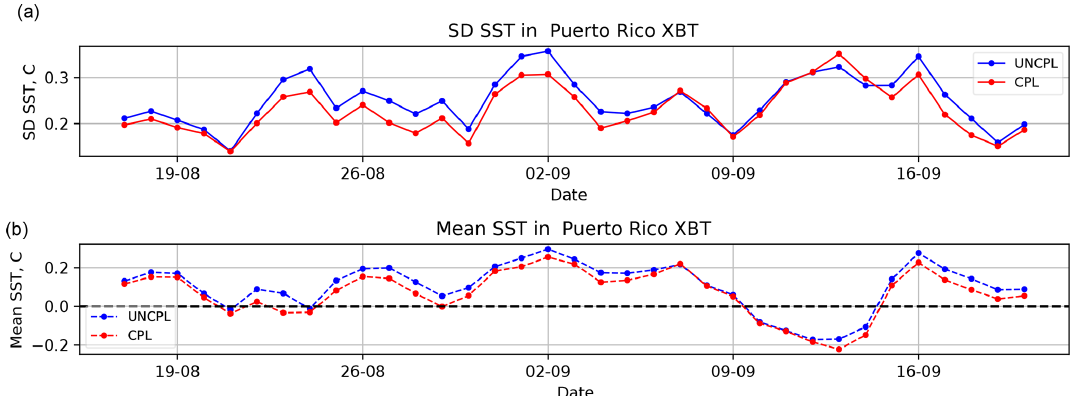
Figure 10. OmF standard deviation (a) and mean (b) with respect to the gridded foundation SST field from the ocean SAM2 DA component for the Puerto Rico XBT region situated within the latitude–longitude box defined by [35, 65 ◦ W] and [25, 35 ◦ N]. The statistics are computed using 24h forecasts.